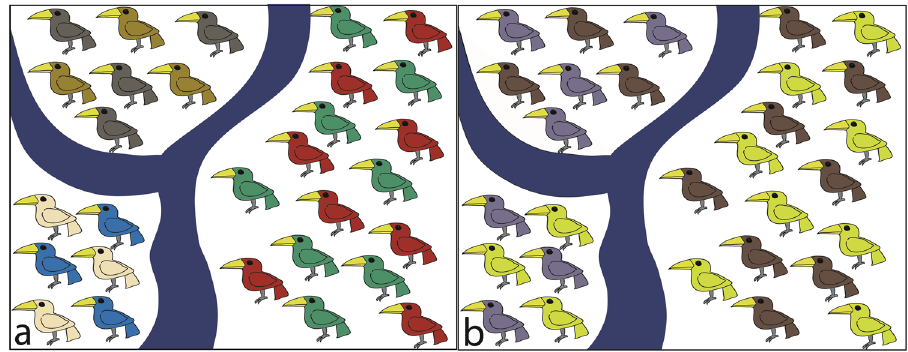
Figure 5. Hypothetical examples illustrating the role of rivers as limits of areas of endemism and as breaks of species composition. As discussed in this study, in ( a ) bird species distribution are confined by rivers, generating areas of endemism in each interfluve. In ( b ), bird species respond differently to each river as a dispersal barrier. Thus, the rivers mark steep changes in species composition, but do not limit areas of